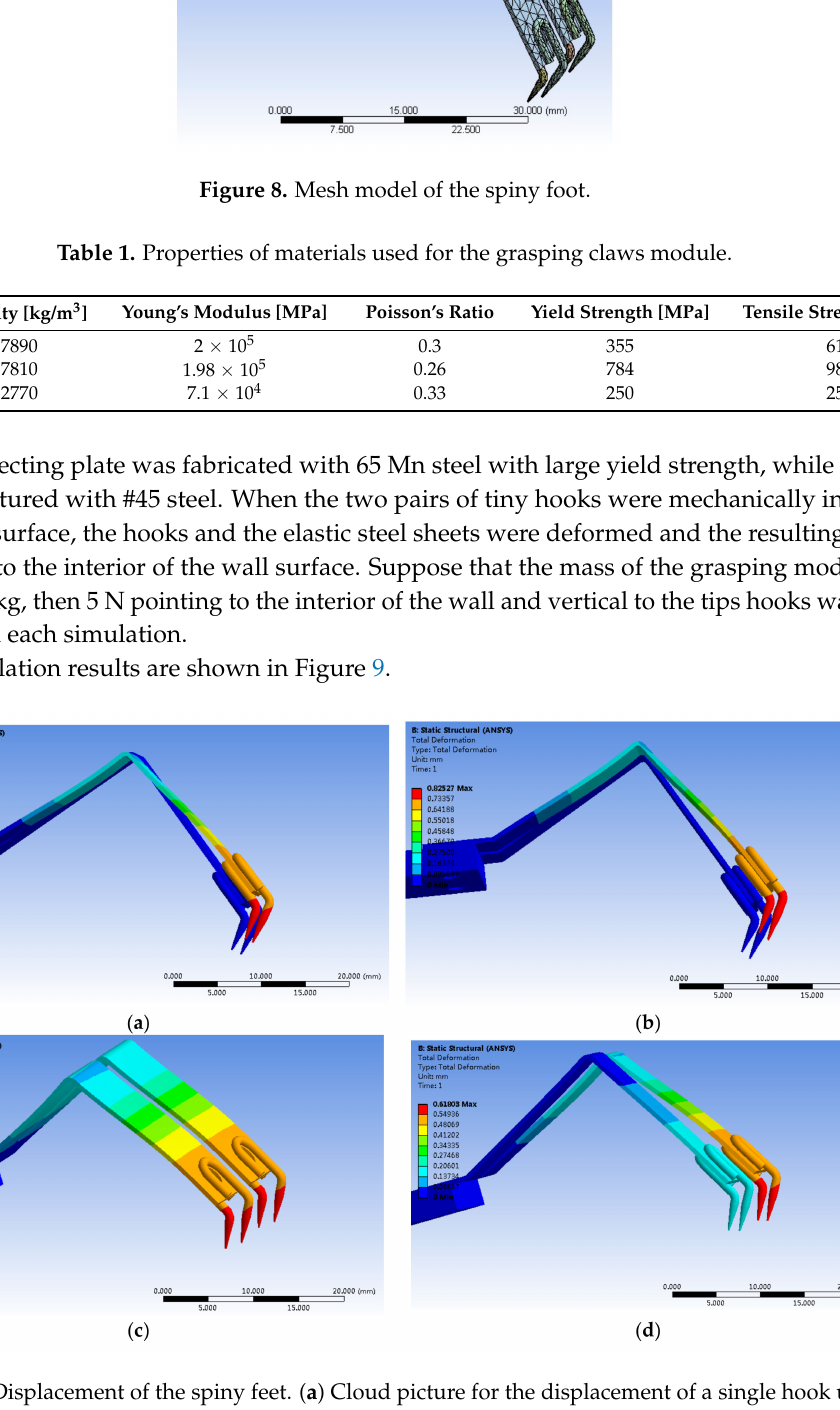
Figure 9. Displacement of the spiny feet. ( a ) Cloud picture for the displacement of a single hook under 5 N; ( b ) Cloud picture for the displacement of a pair of hooks each bearing 2.5 N; ( c ) Cloud picture for the displacement of a pair of hooks each bearing 1.25 N; ( d ) Cloud picture for the displacement of a pair of hooks bearing 3.75 and 1.25 N